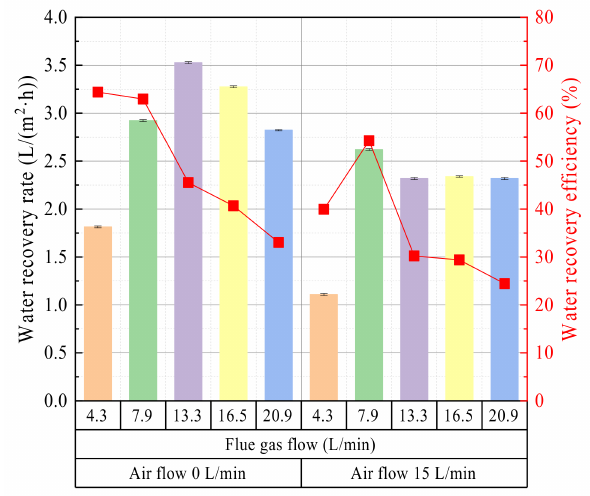
Figure 11. Water recovery rate/efficiency vs. Flue gas flow. Experiment conditions: flue gas inlet temperature 56.36 ◦ C, negative pressure airflow 15 L/min, negative pressure air inlet temperature 14.08 ◦ C, membrane pore size 10 nm.